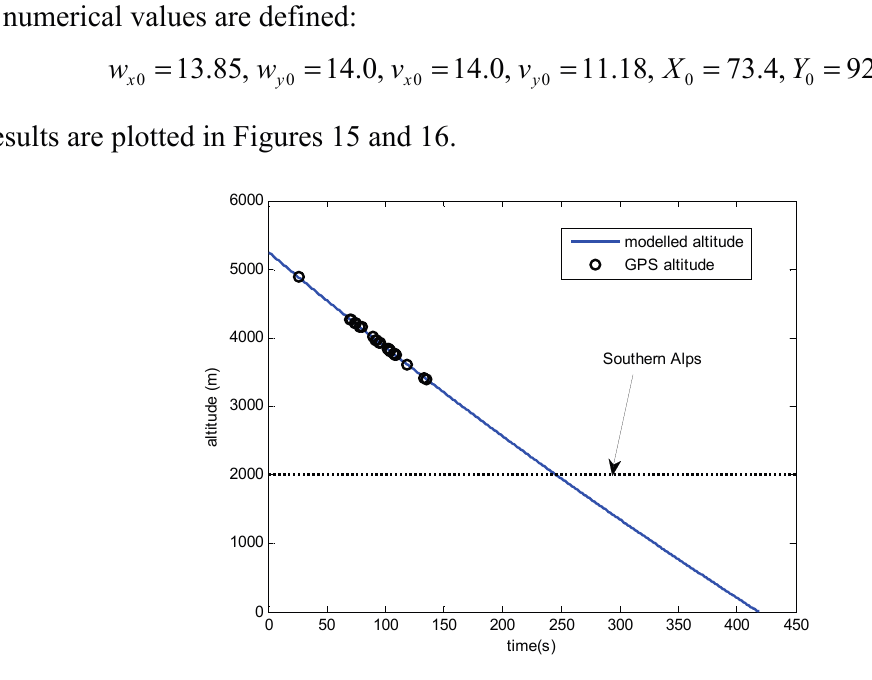
Figure 15. Modelled versus measured